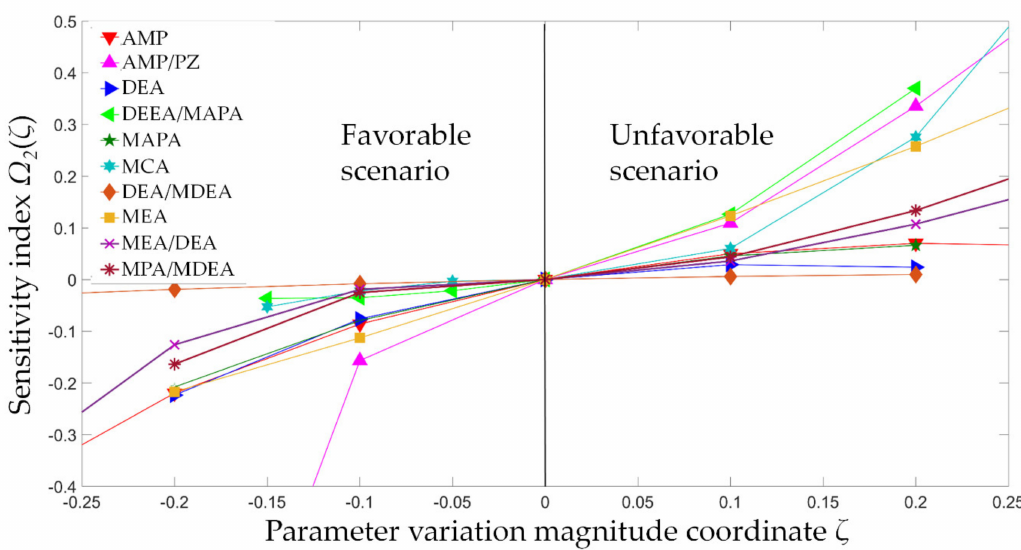
Figure 4. Sensitivity index Ω 2 ( ζ ) versus the parametric variation magnitude coordinate ζ